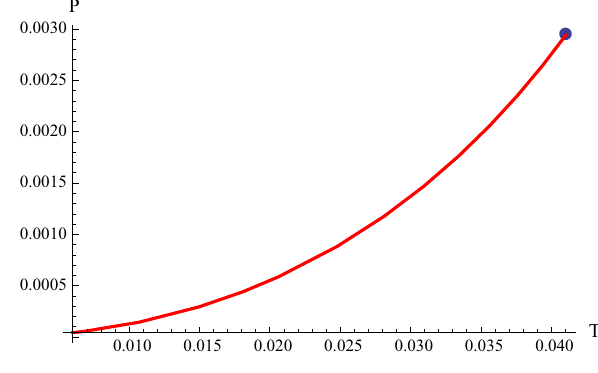
Fig. 4 Coexistence line in P − T plane. We set q = α = 1